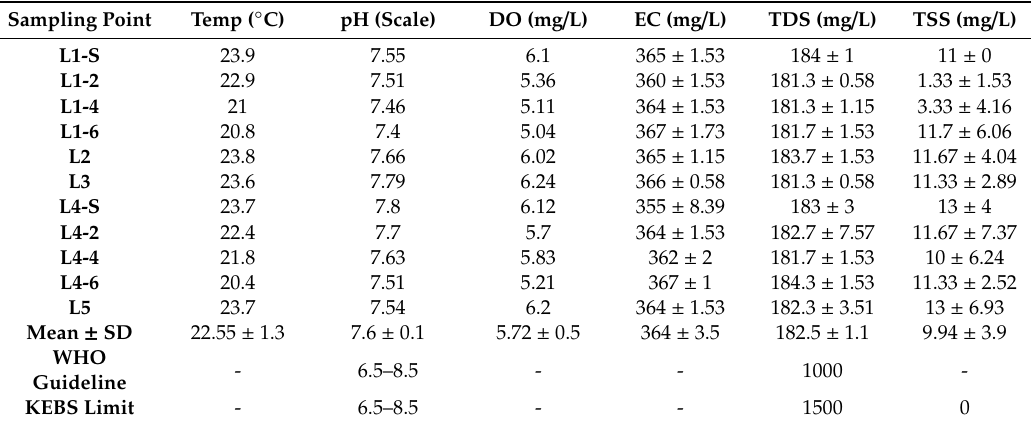
Table 4. Concentration of physical parameters in Rungiri quarry reservoir in August 2019. Sampling